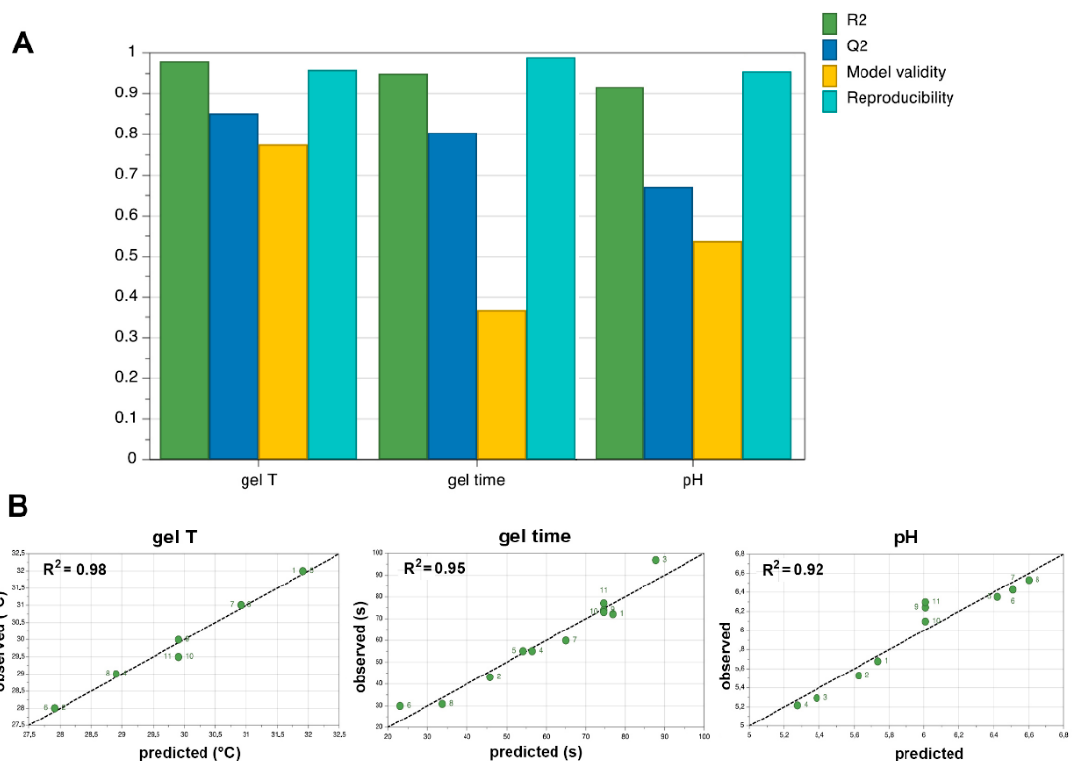
Figure 1. ( A ) Summary of fit plots showing model fit (R 2 ), predictability (Q 2 ), Model Validity and Reproducibility; ( B ) Observed vs predicted plots of gelation temperature, gelation time and